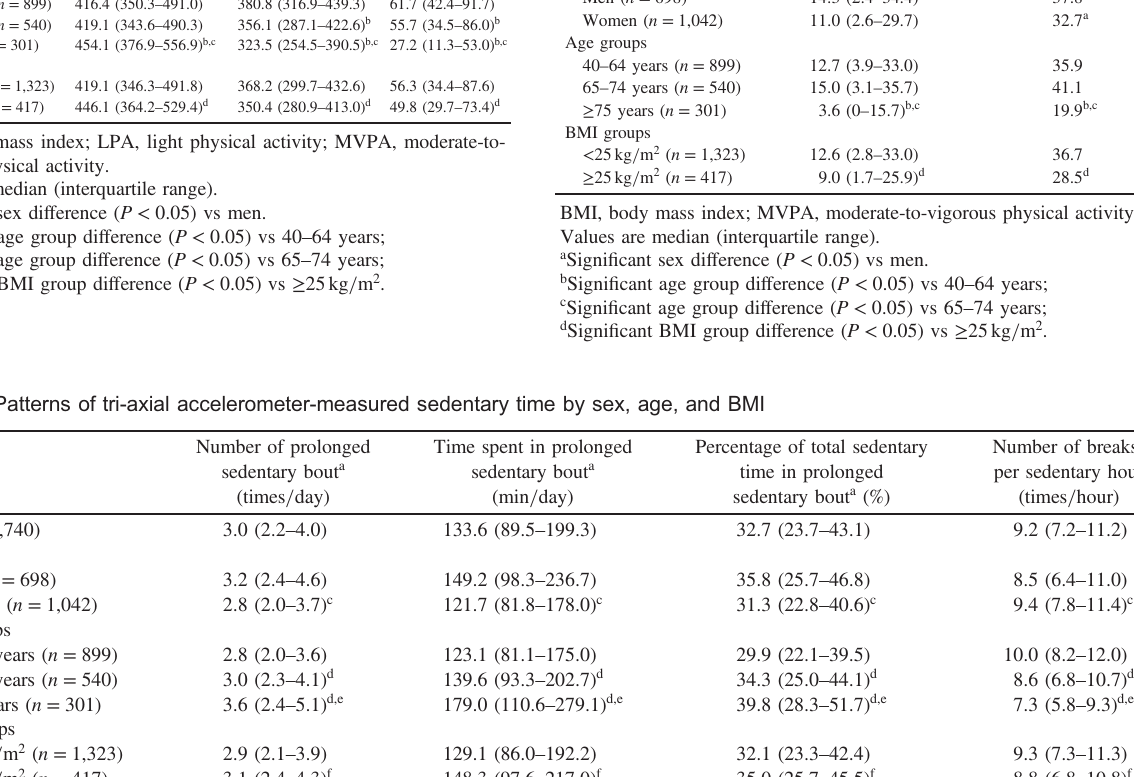
Table 3. Patterns of tri-axial accelerometer-measured MVPA and prevalence of participants meeting the physical activity guideline by sex, age, and BMI MVPA in bouts ≥ 10min (min = day)